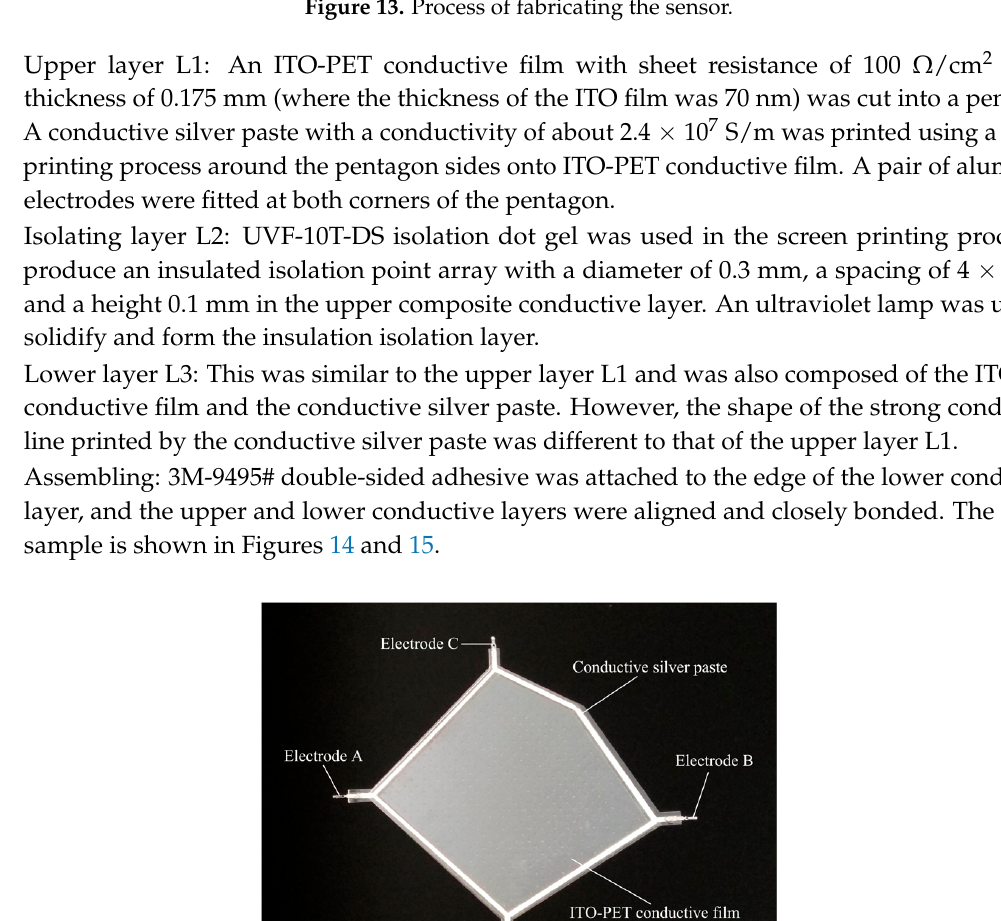
Figure 14. Sensor sample.